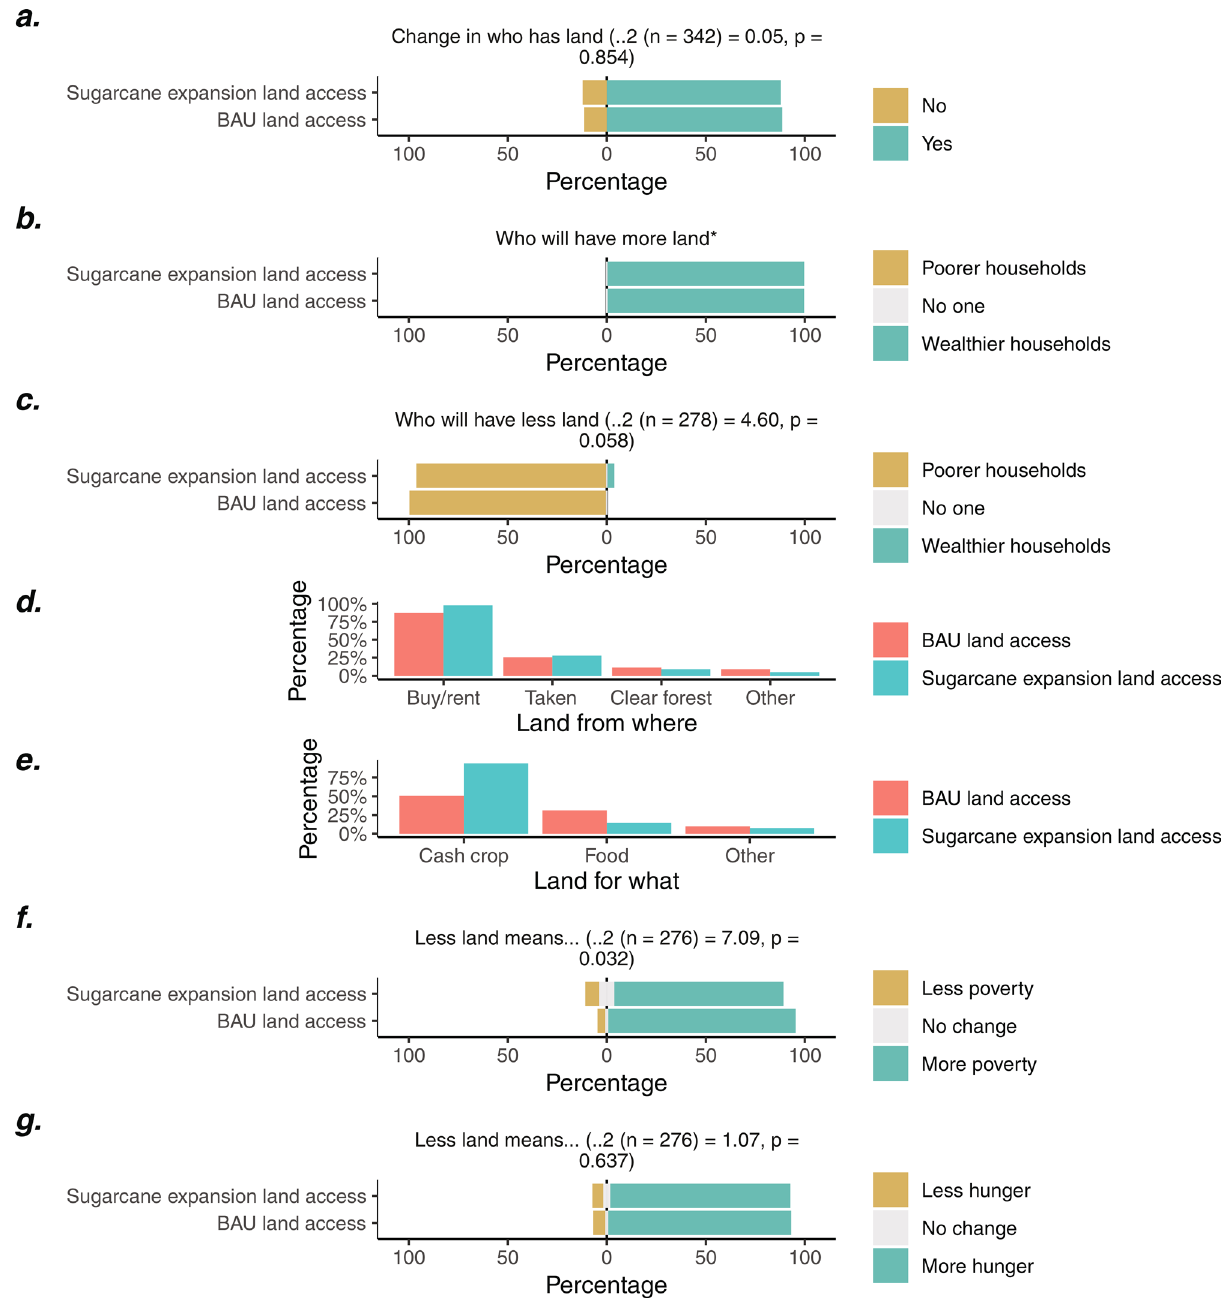
Figure 5. Scenario-based interview responses to two land access scenarios. Panel ( a ) describes the proportion expecting changes in who has land over the next ten years, and panel ( b ) and ( c ) illustrates who is predicted to gain and lose land, respectively (among those expecting a change). Panel ( d ) describes where this land is expected to come from, and panel e. displays what this land might be used for. Panel ( f and g ) illustrate the expected impacts of losing land on household poverty and hunger, respectively. *Where the chi-square test could not be formed because no respondents expected poorer households to gain land. Key: BAU = business-as-